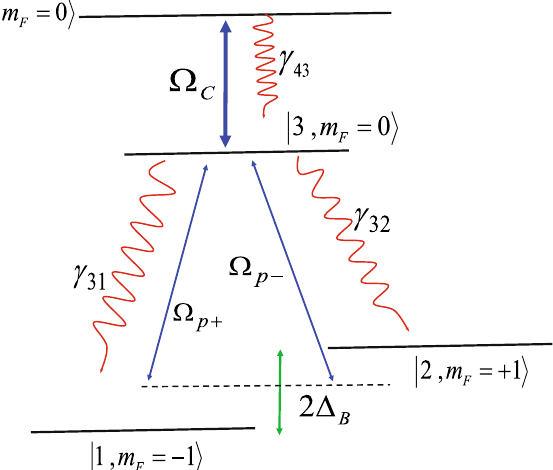
Figure 1. Schematic diagram of an inverted Y-type four-level quantum system. The system is driven by a LG control field with Rabi frequency (cid:31) c , a left- and right-circularly polarized fields with Rabi frequencies (cid:31) p (cid:31) p , respectively, derived from a linearly polarized probe +